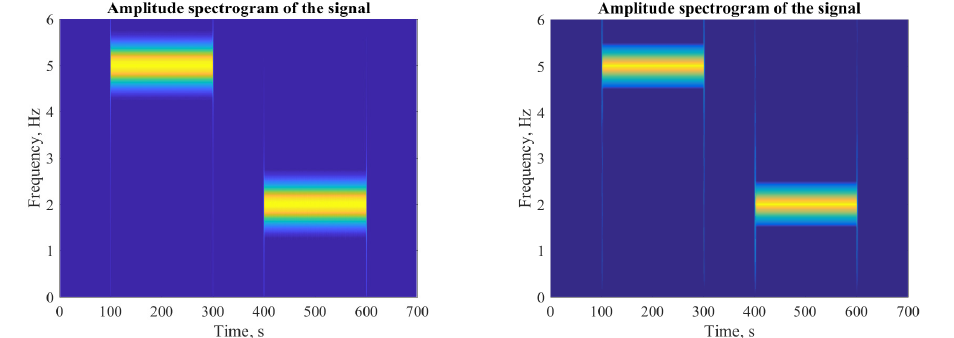
Figure 11. ( a ) STFT spectrogram ( b ) Spectral observer spectrogram.